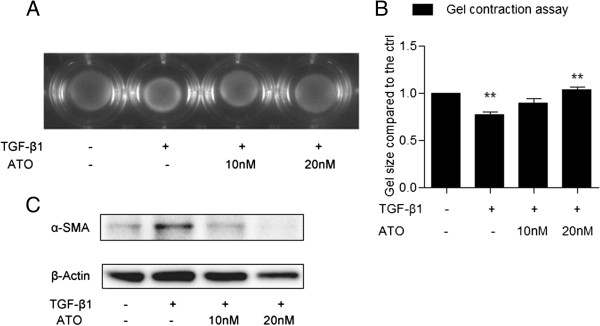
ATO inhibits TGF-β-induced fibroblast contractile activity in rat tail type-I collagen gel. (A) NHLFs were cultured in rat tail type I collagen gels (2 mg/ml) and pre-treated with ATO for 24 hrs. Cells were exposed to TGF-β1 (1 ng/ml) for another 48 hrs. TGF-β1treatment decreased the size of the gel while ATO pre-treatment blocked the reduction in gel size. (B) A summation of the percentage of gel surface area in each well of Figure 2A to the control gel surface area. (C) NHLFs were cultured in rat tail type I collagen gels and treated as described above. Gels were digested using type-I collagenase (5 mg/ml) and cells were harvested in SDS loading buffer for western blot. α-SMA protein expression was induced by TGF-β1 and ATO abrogated the induction. Data represent results from three independent experiments with triplicate repeats. *P value < 0.05, **P value <0.01, ***P value < 0.001.